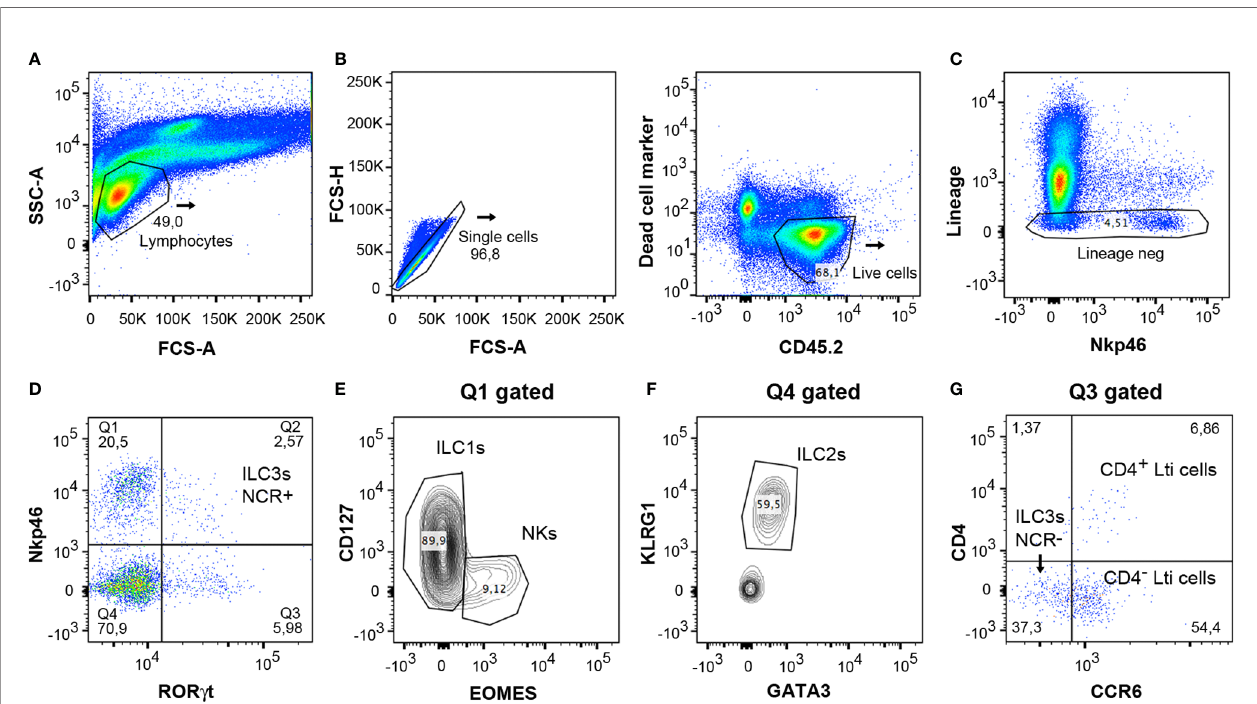
FIGURE 5 | Gating strategy for analysis of innate lymphoid cells from mice colon LPCs. (A) Lymphocytes were gated with the forward scatter/side scatter (FSC/ SSC) method. (B) Single and CD45.2 + live cells were only considered for the analysis. (C) Negative lineage cells were gated to analyze innate lymphocyte cells. (D) Expression of ROR g t and Nkp46 served to distinguish the different populations of ILCs. Q1 included the NK and ILC1 populations. Q2 corresponded to the ILC3 NCR + population (Nkp46 + cells). Q3 included ILC3 NCR - and Lti cells. Q4 comprised the ILC2 population. (E) Staining of CD127 and Eomes was used to differentiate both populations, ILC1s and NKs, in the Q1 gated population. (F) Expression of KLRG1 and GATA3 served to differentiate the ILC2 cells in the Q4 gated population. (G) The Lti subpopulation, gated on Q3, expresses CCR6, and is divided in CD4 + Lti and CD4 - Lti cells. ILC3 NCR - cells, also gated on Q3, do not express CCR6. FSC, forward scatter; SSC, side